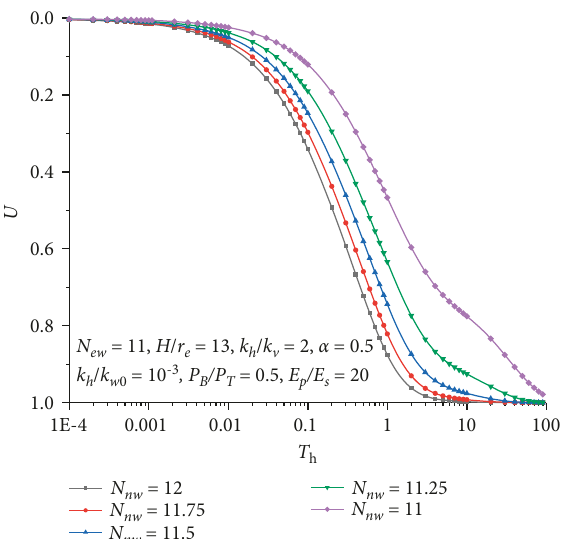
Figure 7: Curve of the effect of P dation process.